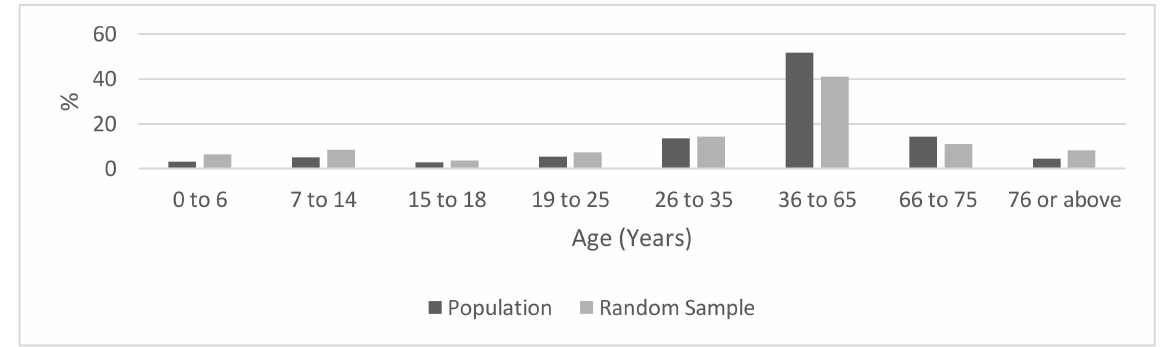
Figure 1. Age distributions of the random study sample and the source